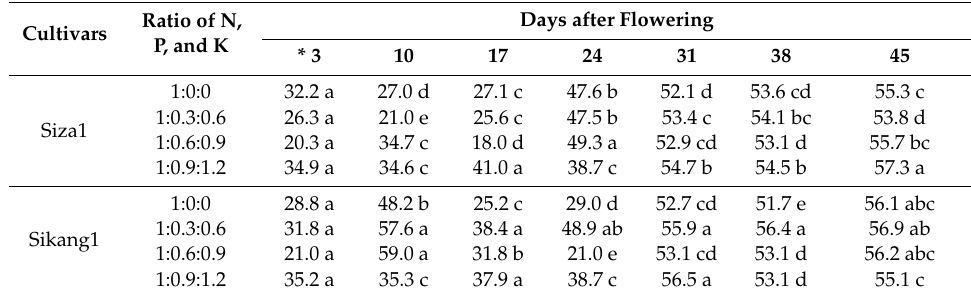
Table 11. E ff ects of the ratio of nitrogen, phosphorous, and potassium application on sugar content mg g − 1 of Siza 1 and Sikang